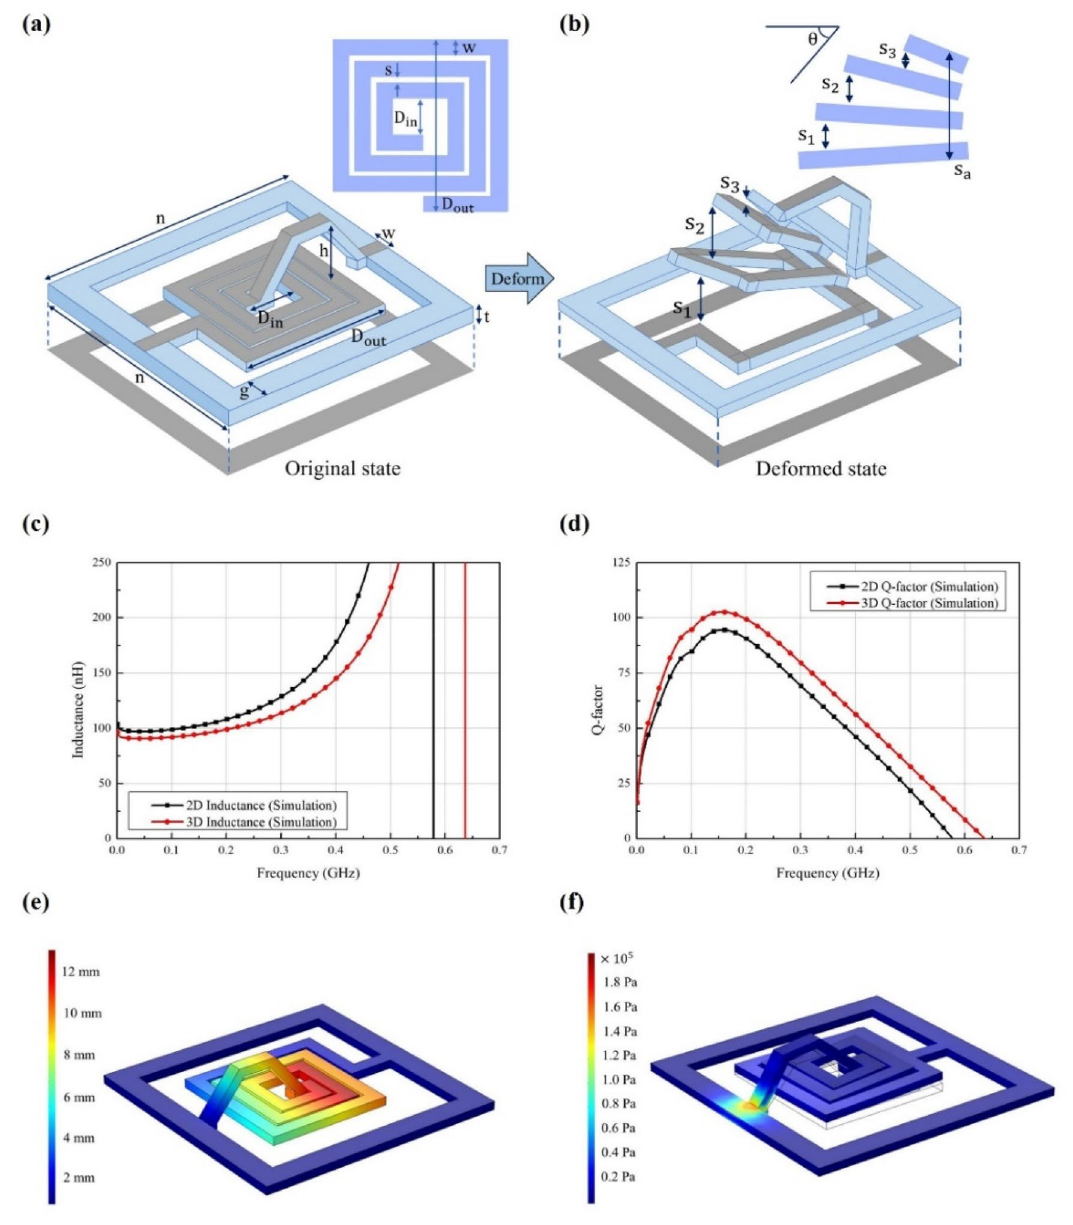
Figure 3. Schematics of the proposed thermal spiral planar inductor in its ( a ) original 2D planar rectangular shape and ( b ) 3D transformed spiral shape. The simulated ( c ) inductance and ( d ) Q-factor of each shape. The simulated ( e ) total displacement and ( f ) stress in the original shape. D in , the internal diameter of the inductor (2.9 mm); D out , the external diameter of the inductor (14.2 mm); n , the outer length and width of the inductor (25.2 mm); h , the height of the air bridge (6 mm); w , the width of the inductor spiral (1.4 mm); g , the width of the surrounding square grid (2.3 mm); S a , the height of the spiral (12.5 mm); S 1 – S 3 , the distances between the inductor lines in the spiral (3.5, 4.5 and 0.5 mm, respectively); a , the angle of transformation air bridge, which closed the surrounding line plane. The COMSOL Multiphysics program was used to simulate total displacement under the applied stress at 75 °C and SMP elastic modulus E = 10 6 . Figure 3e,f show the simulation results for the inductor in the transformed shape: a total displacement of 12.5 mm occurred under a load of 0.03 N perpendicular to the air bridge. In addition, the maximum applied stress of 1.6 × 10 5 Pa was concentrated at the base of the air bridge. Figure 4 shows the measurement results of the characteristics of the fabricated thermal inductor using a vector network analyser (VNA). The results in Fig. 4a show that when considering the surface resistance, the measured inductance results were the same as the simulation results. As the transformed inductor was restored to the original 2D planar spiral inductor shape in the 250 MHz range, the average inductance changed from 117.3 to 140.9 nH (20.12%), respectively. Moreover, the self-resonant frequency decreased from 600 to 528 MHz,